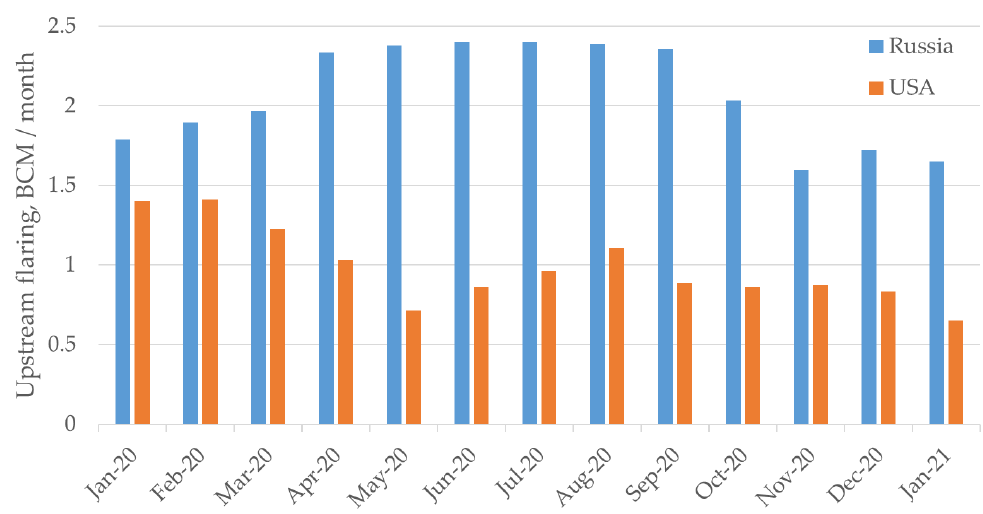
Figure 13. VIIRS Nightfire monthly estimated flaring volumes (in BCM) in Russia and USA in 2020.